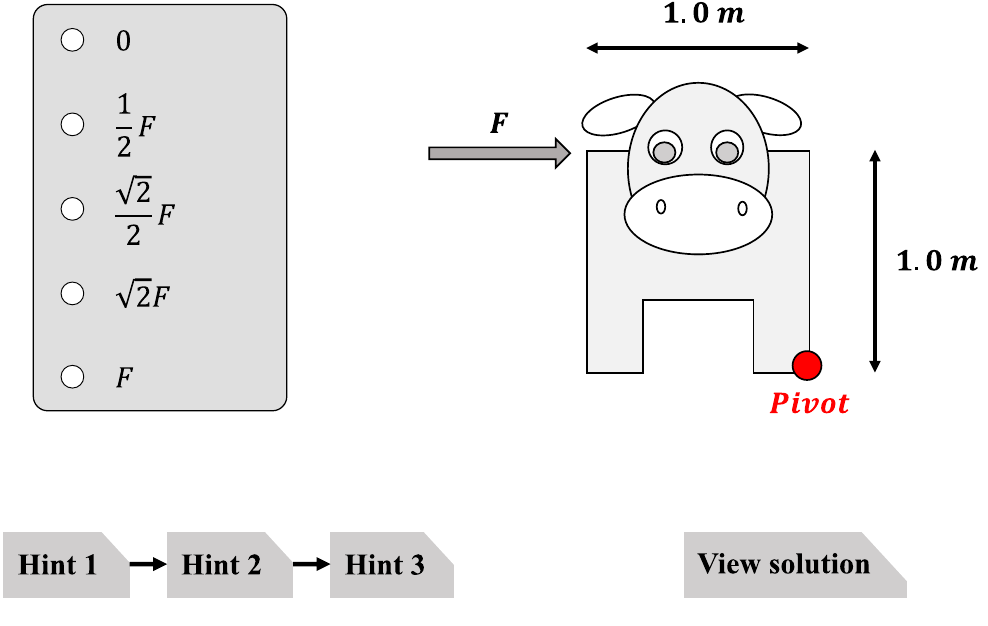
FIG. 7. Example of a subskill targeting torque with arbitrary moment arm